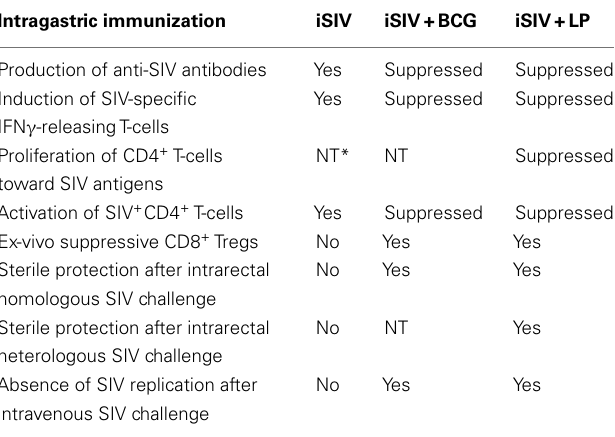
Table 1 | Summary of immunovirological results observed in orally vaccinated monkeys .